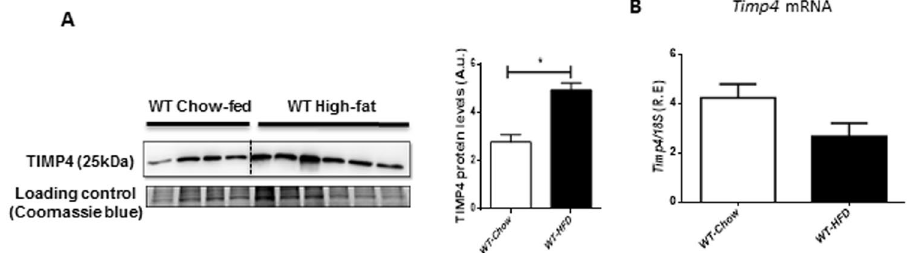
Figure 1. High fat feeding increased TIMP4 protein levels in adipose tissue. ( A ) Representative Western blot and averaged protein quantification for TIMP4 in epididymal fat pads in WT mice following chow or high fat diet (HFD). Coomassie blue-stained gel is used as the loading control. ( B ) Timp4 mRNA expression in WT-chow and WT-HFD. 18S rRNA was used as internal control. n = 4–6. Averaged data are presented as mean ± S.E.M and analyzed by student’s t-test analysis. * indicates significance (p ≤